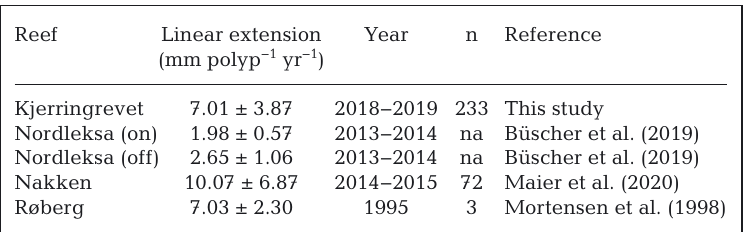
Table 3. Linear growth (mean ± SE) from Norwegian coastal and fjord reefs. n: number of polyps that were measured for growth. na: not